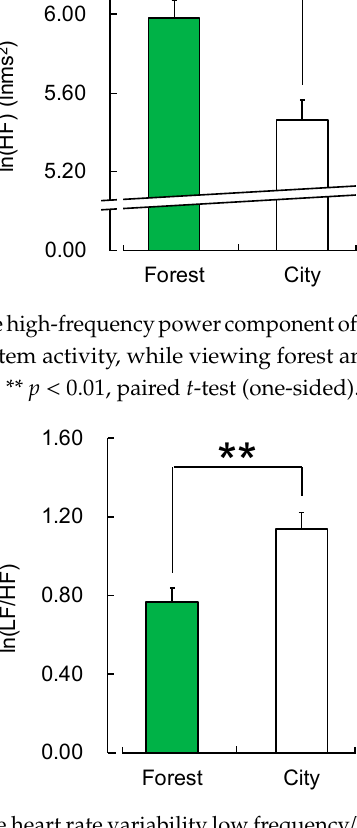
Figure 4. Heart rate during viewing forest and city areas. Data are shown as means ± standard error ( n = 65). ** p < 0.01, paired t -test (one-sided). The present results were compared with results from our previous study in which participants walked in forests [18]. The numbers and ratios of participants who indicated positive and negative responses in forests are summarized in Table 3. In our previous results [18], 86.5% of the participants exhibited positive responses for ln(HF) during walking in forests, which was a greater proportion than that during viewing (75.4%) in the present study, although the difference was not statistically significant. The proportion of participants showing a positive response in ln(LF/HF) was similar between walking in forests (71.2%) and viewing forests (78.5%); again, there was no statistically significant difference. Table 3. Numbers and proportions of participants who showed positive and negative responses in heart rate variability indices during walking in and viewing forests. ln(HF)